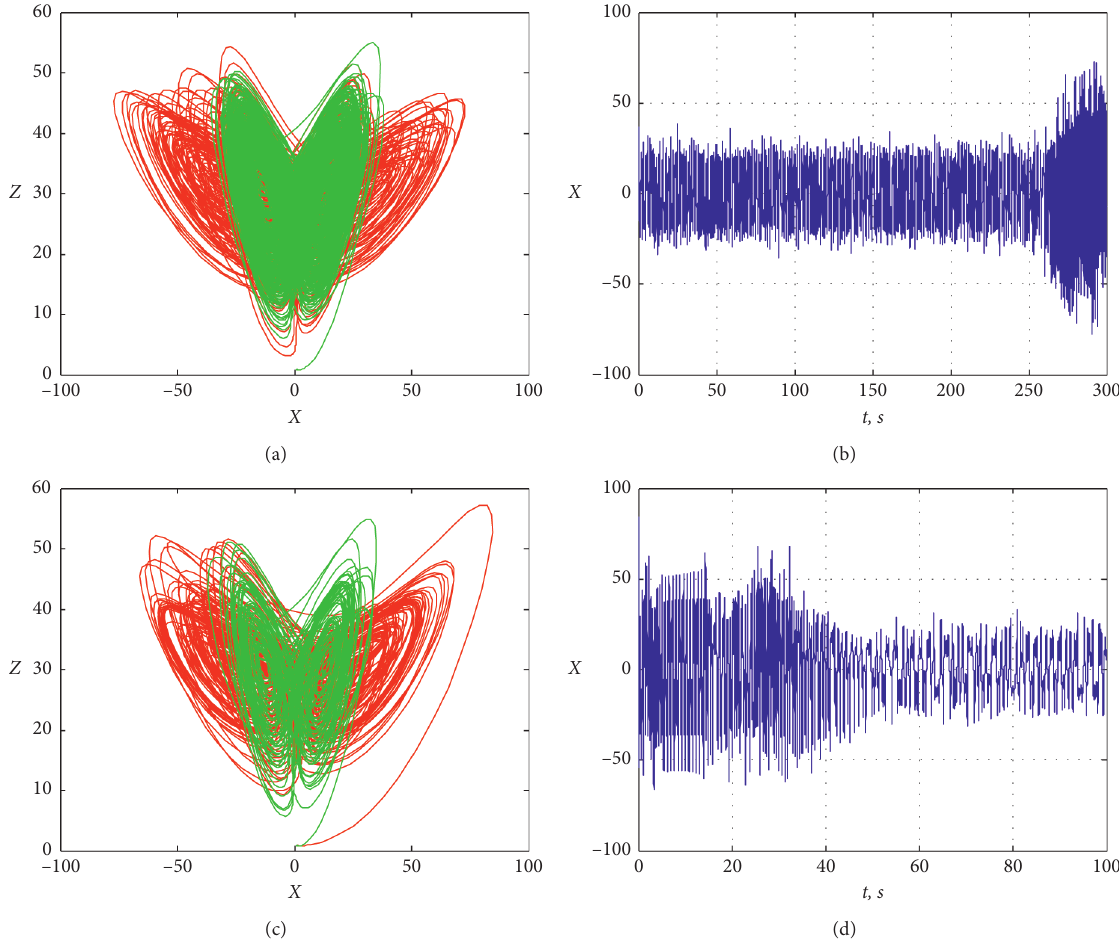
Figure 9: Transient hyperchaotic behavior: (a) and (c) are phase portraits; (b) and (d) are time-domain waveforms; the system parameter ρ � 27 in (a) and (b), whereas the memristor initial condition U (0) � − 14 in (c) and